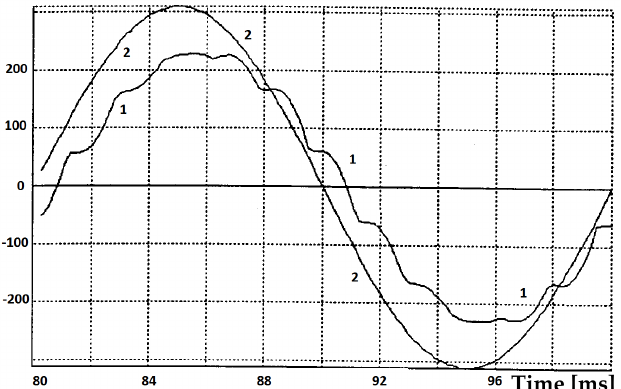
Figure 9. Current waveforms: 1 – network phase current, 2 and 3 - 3CR  winding currents i 1 R/ 2 / , i 2 R/ 3 / 4 - intermediary circuit current i d/ 4 / for the 2 kW load.